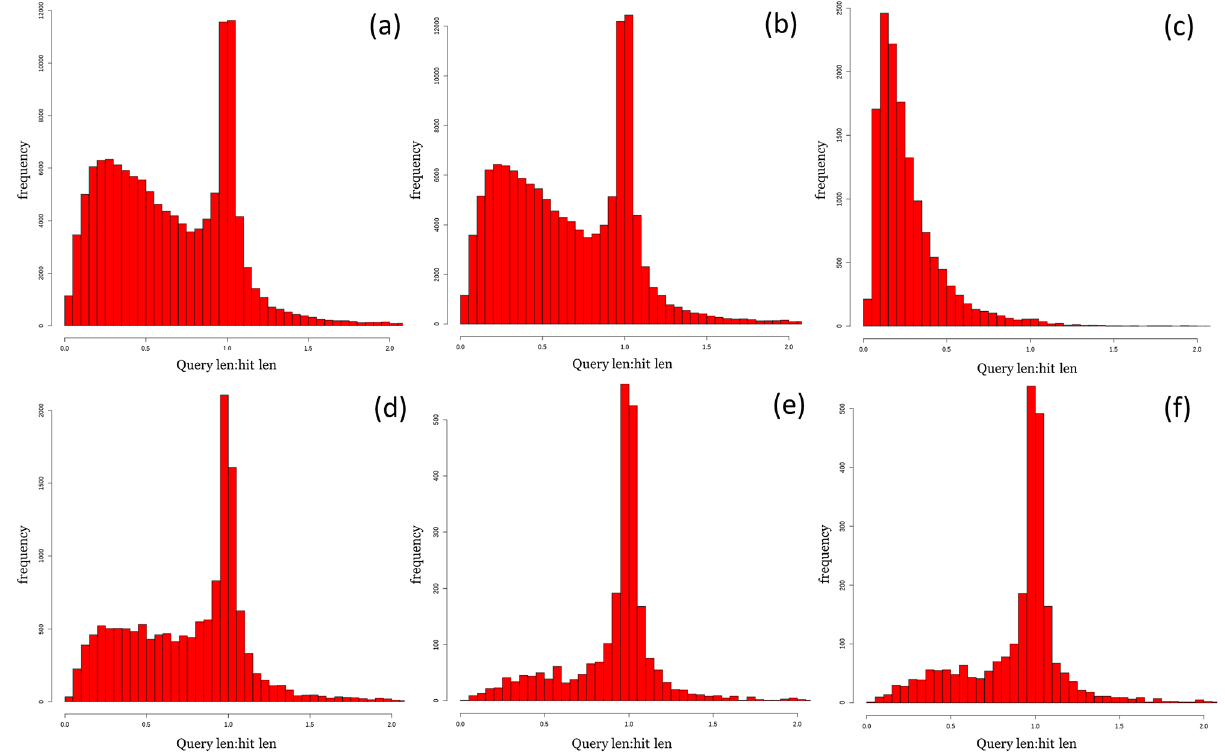
Figure 3. IDEEL plots of frequency (y-axis) vs. query length:hit length (x-axis) for: ( a ) hybrid metagenome; ( b ) HiSeq metagenome; ( c ) MinION metagenome; ( d ) polished MinION metagenome (MinION_RD); ( e ) Hybrid_5 MAG; ( f ) HiSeq_31 MAG. Query length:hit length is the ratio between the contig and its best match in the UniProt TREMBL database. If the contig contains few indels, this ratio will be ~